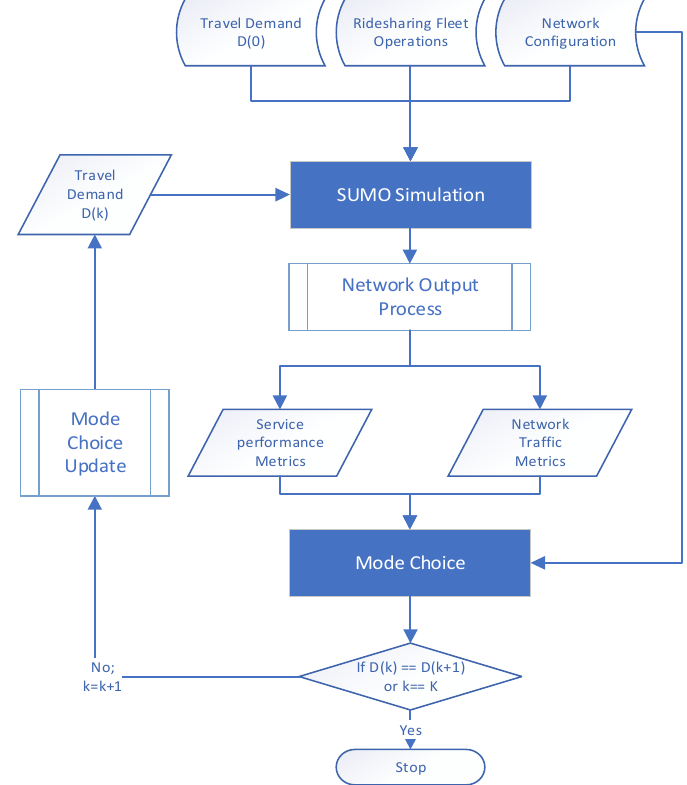
Figure 1. Framework of the simulation-based shared mobility model.